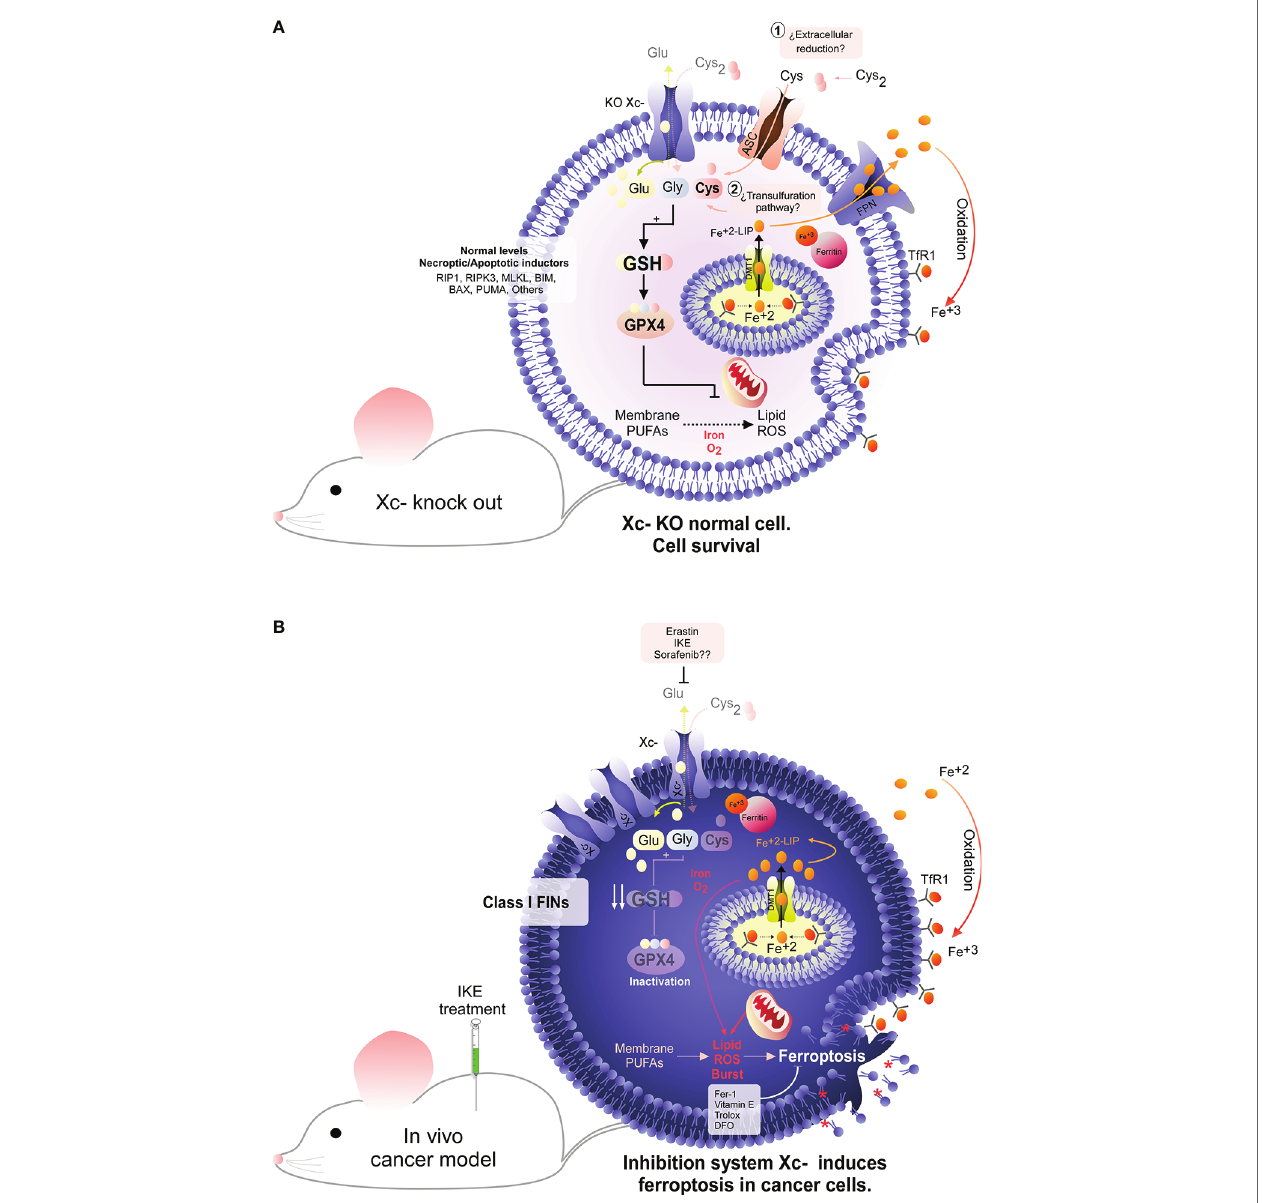
FIGURE 2 | System x − c dependence in cancer cells. Under physiological conditions, the nonessential amino acid cysteine is present as cystine due to the extracellular oxidative environment. To maintain a stable intracellular cysteine level, the presence of the cystine/glutamate antiporter (system x − c ) is necessary. Interestingly, genetic deletion of system x − c does not produce any damage in animals, suggesting that normal cells do not depend on this antiporter to maintain the intracellular cysteine level. In line with this idea, compensatory mechanisms, such as the transsulfuration pathway, may exist for the recovery of the intracellular cysteine level (A) . Conversely, it has been widely described that tumor cells have a high dependence on system x − c for the cellular uptake of cysteine (B) . Pharmacological inhibition of this antiporter results in the depletion of intracellular cysteine, inducing an abrupt decrease in the GSH level, which ultimately triggers inactivation of GPX4, the main hydroperoxidase in the cell. Inactivation of GPX4 due to inhibition of system x − c results in an overwhelming overload of lipid ROS that ultimately induces tumor death by ferroptosis (B) . Interestingly, it has been determined that inhibition of system x − c can induce tumor death both in vitro and in vivo , identifying this antiporter as a potential therapeutic target for